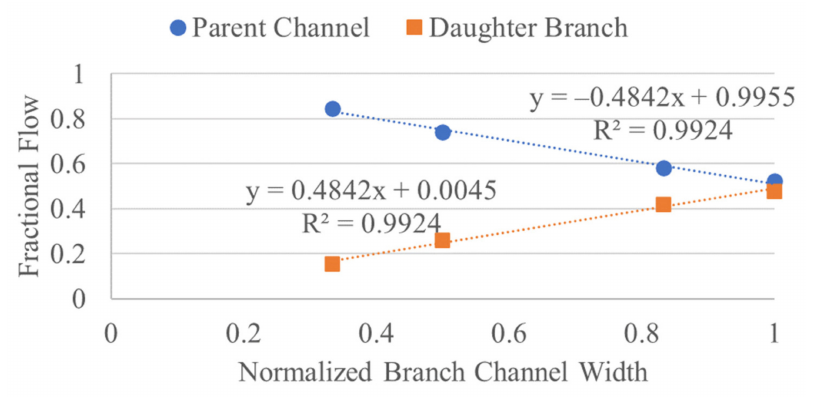
Figure 7. Plot of fractional flow in 90-degree T-junction for different branch